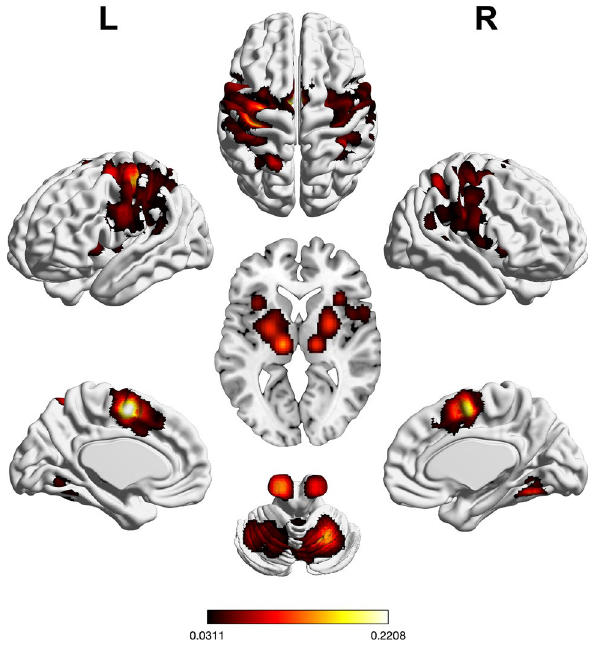
Figure 4. Foci of brain activity showing significant convergence of activity for motor execution (cluster- level p < 0.05, family-wise error-corrected for multiple comparisons, cluster-forming threshold at voxel level: p < 0.001). The scale bar reflects activation likelihood estimation scores. Cortical and cerebellar clusters of convergence were visualized with the BrainNet Viewer 24 ; subcortical clusters were rendered on the individual anatomical template (“ch2better”) provided with MRIcron 25